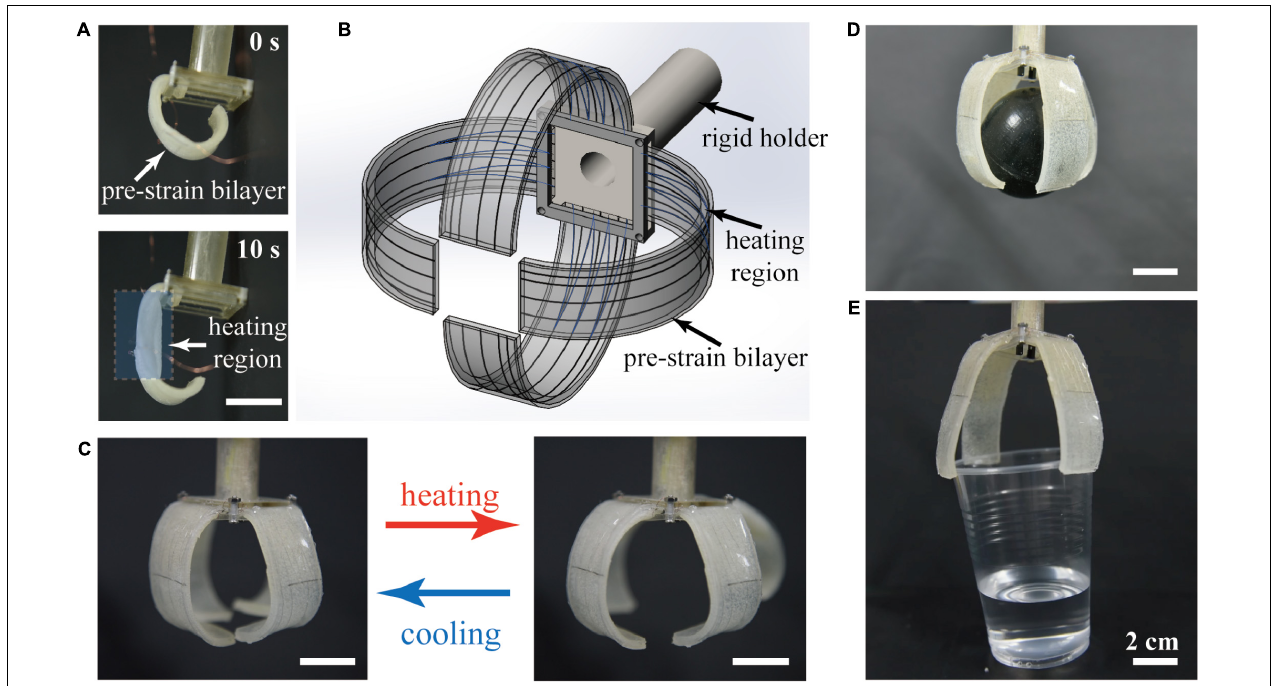
FIGURE 7 | Energy-free gripper based on 4D printing pre-strained bilayer. (A) Rapid deformation of pre-strained bilayer upon heating. (B) Schematic of pre-strained soft gripper composed of four identical pre-strained bilayers. (C) initial closed “fingers” open upon heating and closes upon cooling. (D,E) Demonstration of grasping of a sphere with a weight of 40 g, and a plastic cup filled with water with a weight of 70 g. The weight of the soft gripper is 20 g.